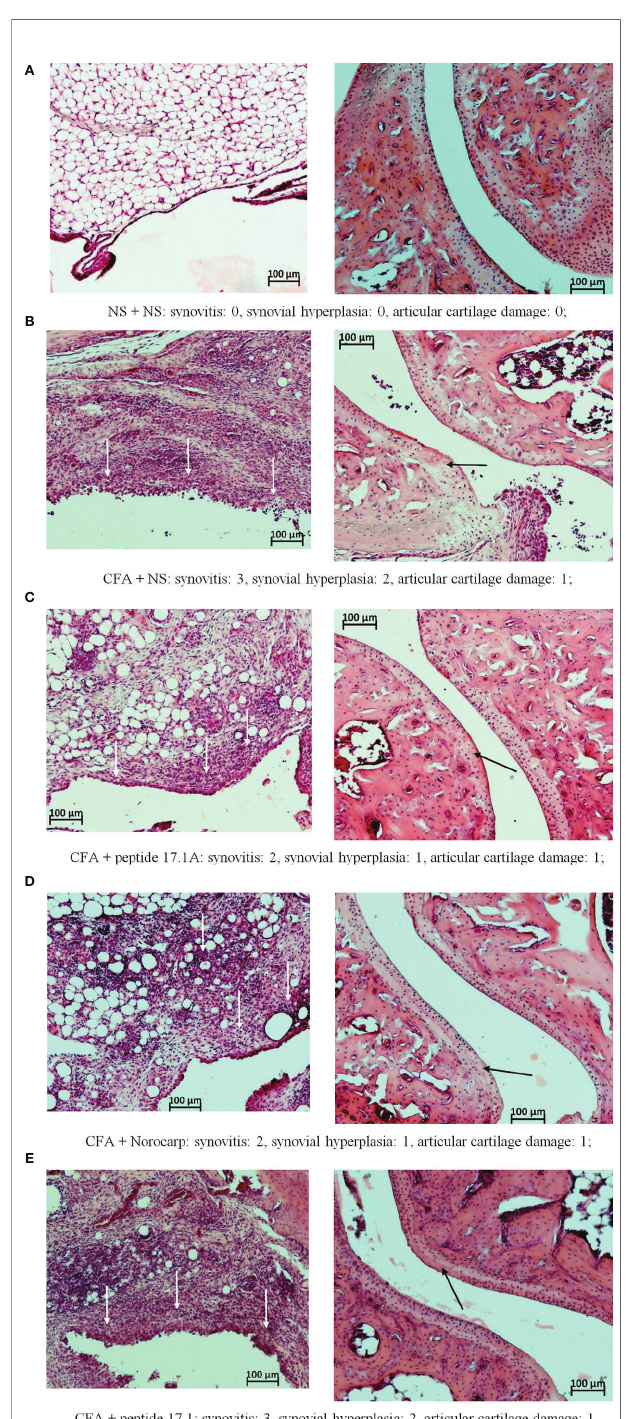
FIGURE 7 | Fragments of the synovial membrane (left column) and the articular surfaces of hyaline cartilage (right column) of the left ankle joint of a mouse at day 10 in the control (A) and in the model of CFA-induced arthritis after injections of normal saline (B) , peptide 17.1A (C) , Norocarp (D) , peptide 17.1 (E) . The severity of synovitis and synovial hyperplasia (white arrows), as well as articular cartilage damage (black arrows) were assessed semi-quantitatively. H&E staining. Magni fi cation